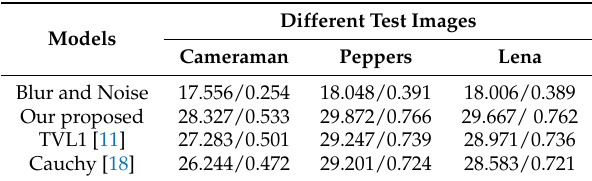
Figure 8. The magnified local regions of the recovered Fruits images from different methods. Table 2. The PSNR (dB)/SSIM for blurred and noisy images and recovered images.